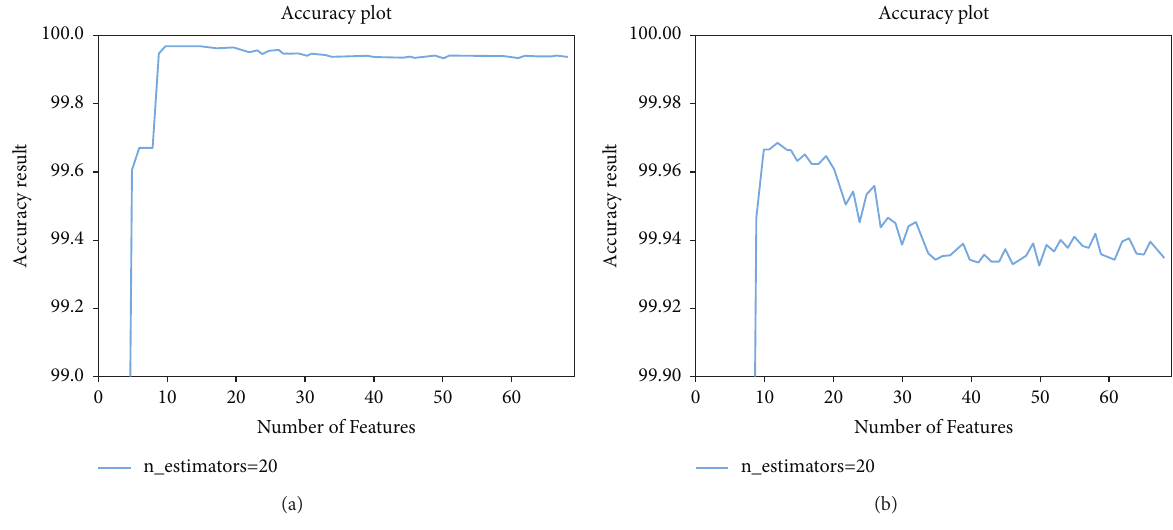
Figure 5: Accuracy score of best performing estimator. (a) Accuracy score above 99%. (b) Accuracy score above 99.9%. Table 3: Classification report of the best performing estimator. Table 4: Classification status of the best performing